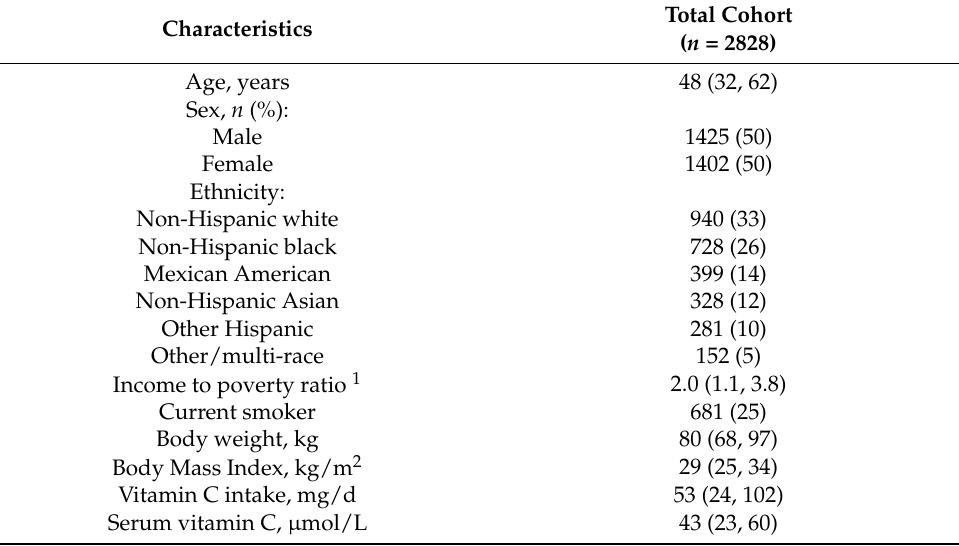
Table 1. Cohort characteristics.